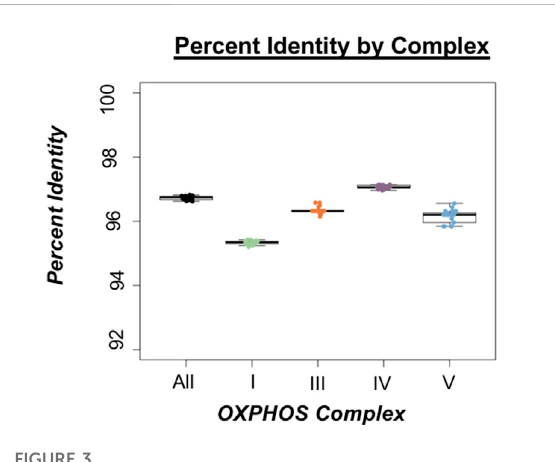
FIGURE 3 Percent identity of oxidative phosphorylation (OXPHOS) complexesinthreespine stickleback( Gasterosteusaculeatus ). Box plots indicate the spread of percent identity between the Trans- North-Paci fi c (TNP) reference genome from North America and Euro-North American (ENA) mitogenomes from North America. Color choices areconsistent throughout